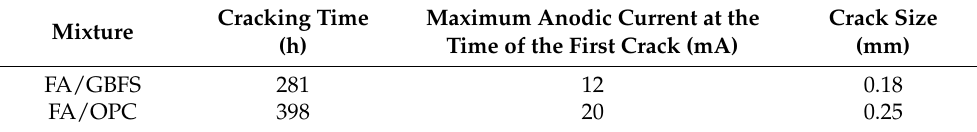
Table 3. Results of Impressed voltage test on reinforced concrete (FA/GBFS, FA/OPC and OPC).